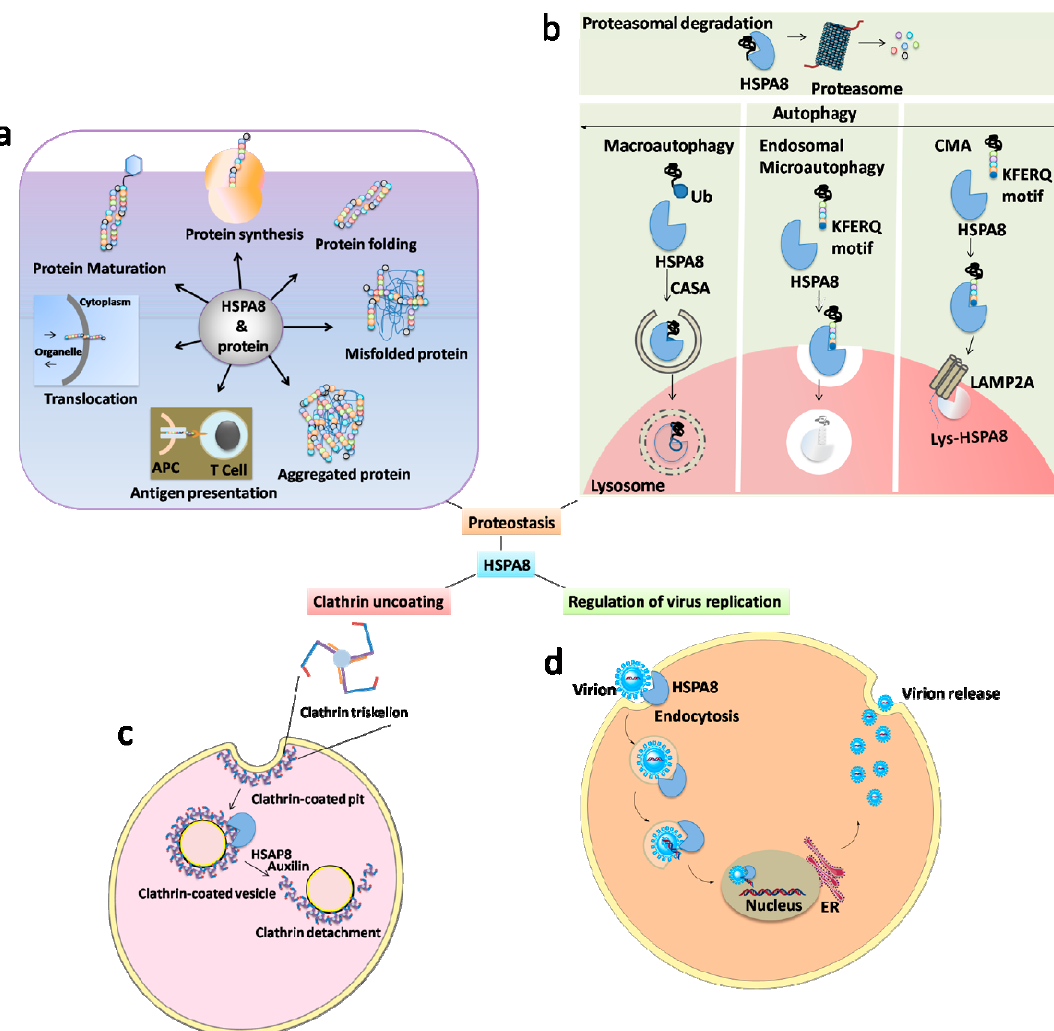
Figure 1. The broad spectrum of HSPA8 functions. HSPA8 with its co-chaperones and cooperating chaperones constitute a complex network of folding machines. It is therefore involved in many decisive aspects of cell survival. ( a ) Protein regulation: HSPA8 is a well-known protein regulator in terms of folding, maturation, translocation, assembly, disassembly, aggregation, antigen presentation and differentiation. ( b ) HSPA8 is determining in autophagy (CASP, CMA, microautophagy) and ubiquitin–proteasome system. ( c ) Uncoating of clathrin-coated pits: HSPA8 uncoates the clathrin triskelions from clathrin-coated pits, which are involved in several processes of intracellular pathways (e.g., cycles of endocytosis of the synaptic vesicles and receipts trafficking). This proceeds in an ATP-dependent manner with the help of auxilin. ( d ) HSPA8 is also known to